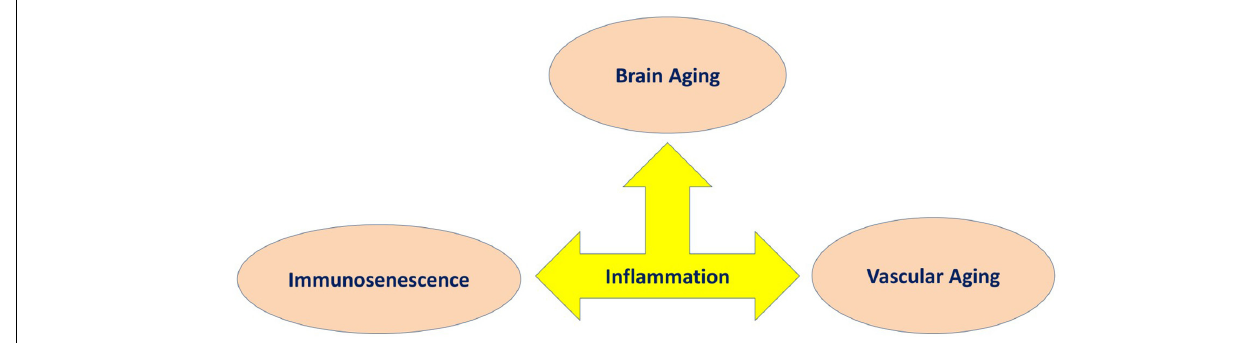
FIGURE 3 | Inflammation as a common underlying mechanism in three main features of aging involved in cognitive decline.